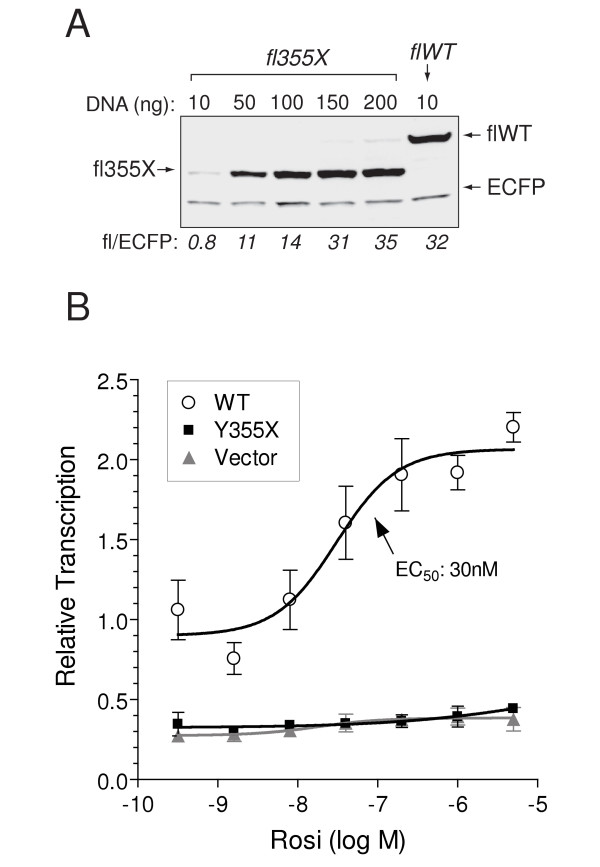
Y355X mutation reduces PPARγ protein stability and transcriptional activity. (A) Western blot of lysates from NIH 3T3 cells transfected with the indicated amount of plasmid expressing either FLAG tagged Y355X (fl355X) or wild-type (flWT) PPARγ proteins. PPARγ was visualized with anti-FLAG antibodies and ECFP produced from co-transfected plasmid (visualized with an anti-ECFP antibody) was utilized as a transfection and loading control. The numbers below the panel represent the density of each PPARγ-FLAG band normalized to the ECFP band. Roughly equal amounts of mutant and WT protein expression were achieved by a 15 fold excess of transfected mutant over WT PPARγ DNA. (B) Rosiglitazone dose-response curves for WT and Y355X PPARγ in NIH 3T3 cells transfected with 1 ng of WT or 15 ng of Y355X expression plasmids (non-FLAG-tagged versions) or 15 ng of empty vector, together with a PPAR responsive reporter construct (pFATP-luc) and a β-galactosidase reference plasmid. Data are normalized to the WT vehicle controls and are means ± SD (n = 3).